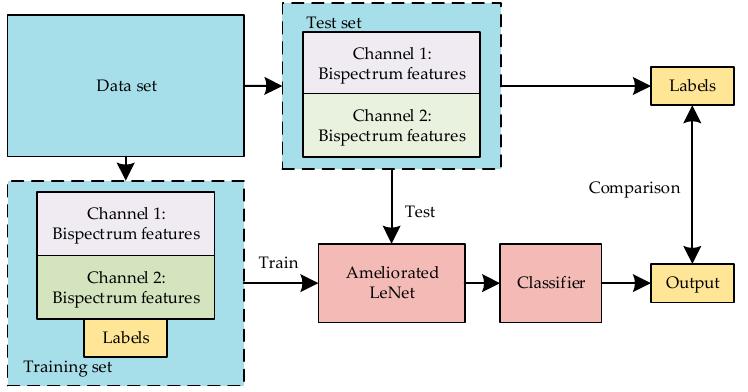
Figure 10. The structure of the proposed algorithm.